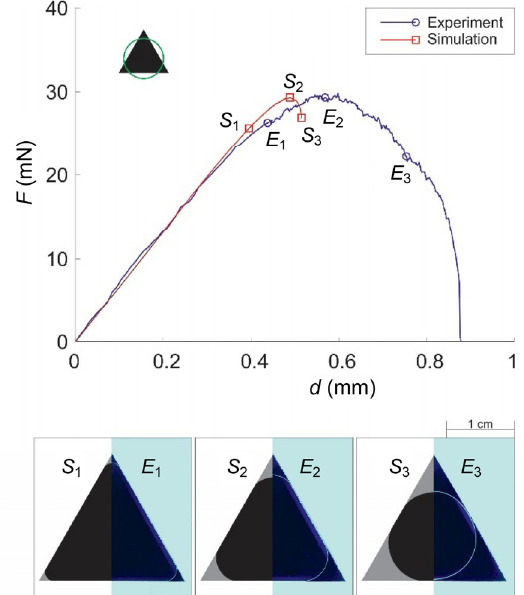
Fig. 13 Dependency of the attracting force on the pull-off distance for a triangular shape. The blue curve represents experimental data, while the red curve is obtained by simulation. The simulation results were fitted to the experimental data by assuming * 6.02 kPa E  and 1 0.062 N m .     Highlighted points ( S 1 , S 2 , S 3 , E 1 , E 2 , E 3 ) 12 refer to Fig. 13 (below). The green circle in the shape representation depicts the equivalent Holm-radius of the triangular shape. In the lower part, the real contact area for selected pull-off-states is shown. All three pictures show numerical results on the left hand side, where the initial shape is gray, and remaining contact area is black. The right hand sides show photographic images of the contact. The edge of the contact zone can be seen as a bright